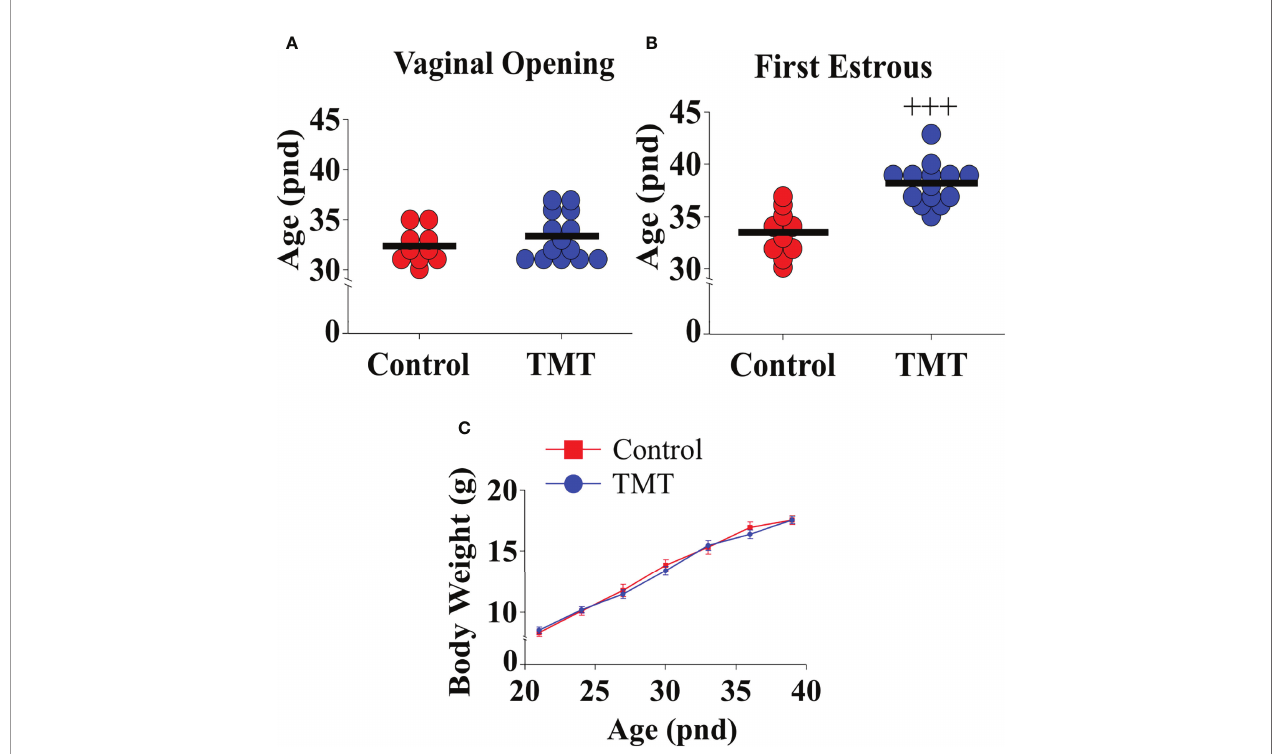
FIGURE 3 | Female C57Bl6/J mice chronically exposed to 2,4,5-Trimethylthiazole (TMT) from post-natal day (pnd) 21 for 14 days showed delayed fi rst estrous (FE) without affecting vaginal opening (VO) and body weight (BW). Effect of chronic TMT exposure on day of VO (A) , FE (B, C) BW weight gain between pnd 21 and 45. F (1,22) = 29.42, +++p<0.0001 Control group (combined water control: n=6; ethyl vanillin control: n=4) vs TMT group